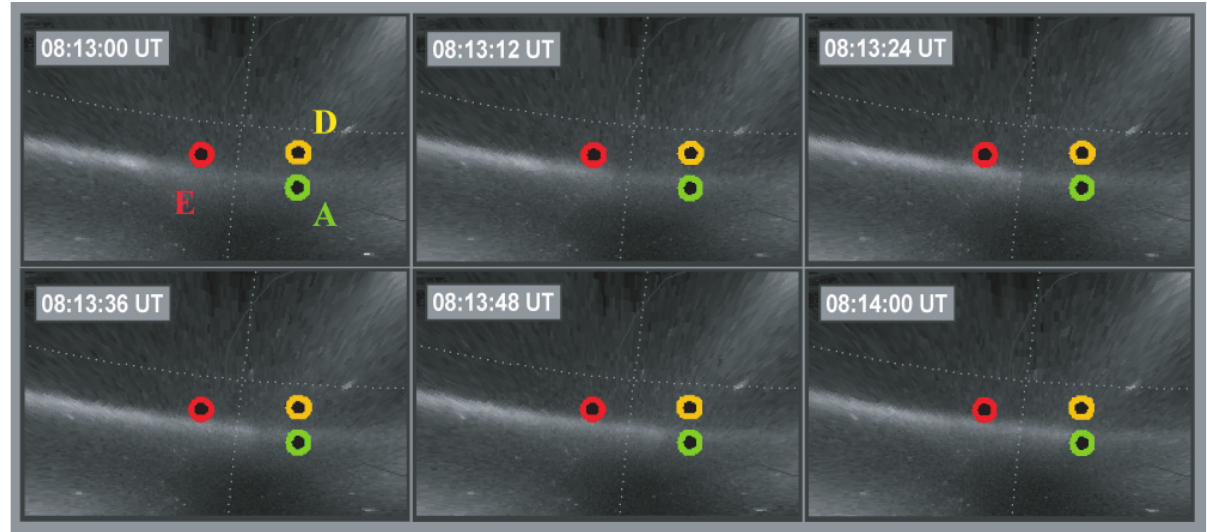
Fig. 2. Auroral images expanded from Fig. 1 in the vicinity of the footprints of THEMIS D (yellow), E (red), and A (green) at 08:13:00– 08:14:00UT on 10 January 2008.